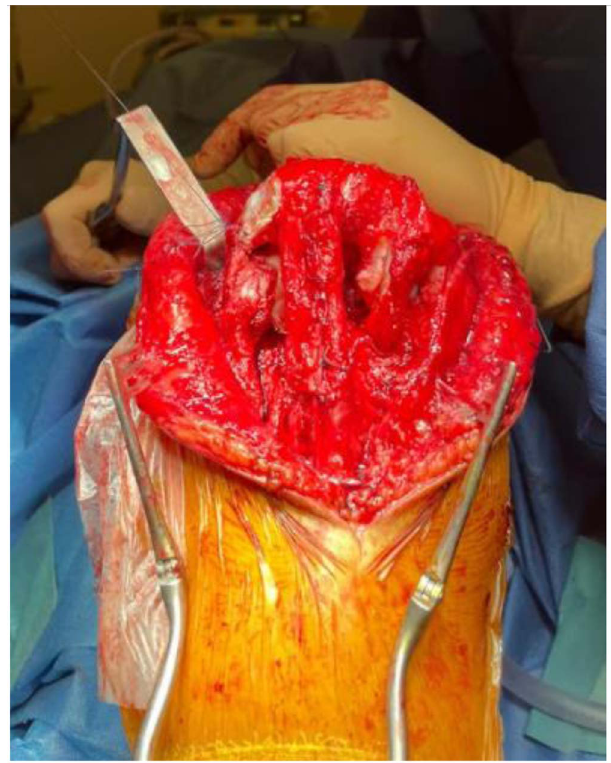
Figure 6. Patellar tendon suture and reinforcement.